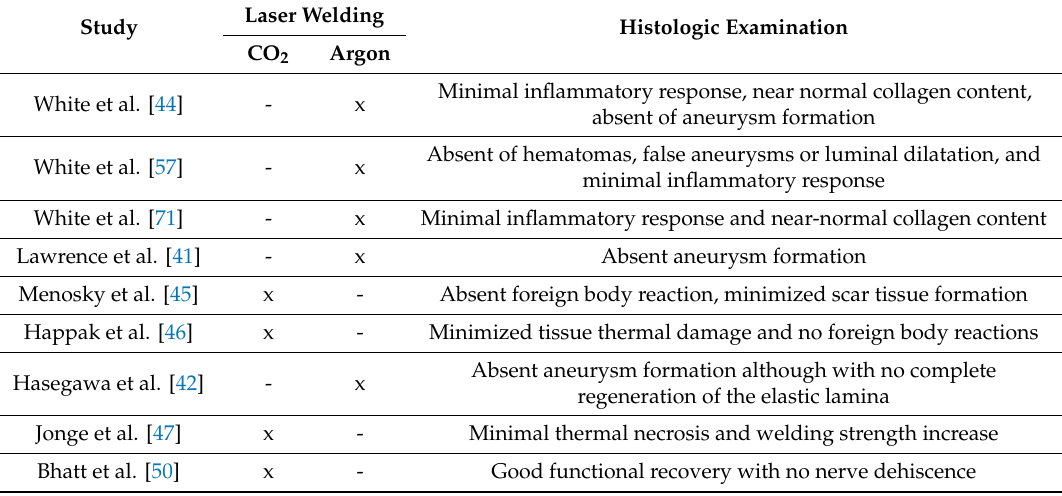
Table 4. Overview of histological results of CO 2 and argon repairs over conventional